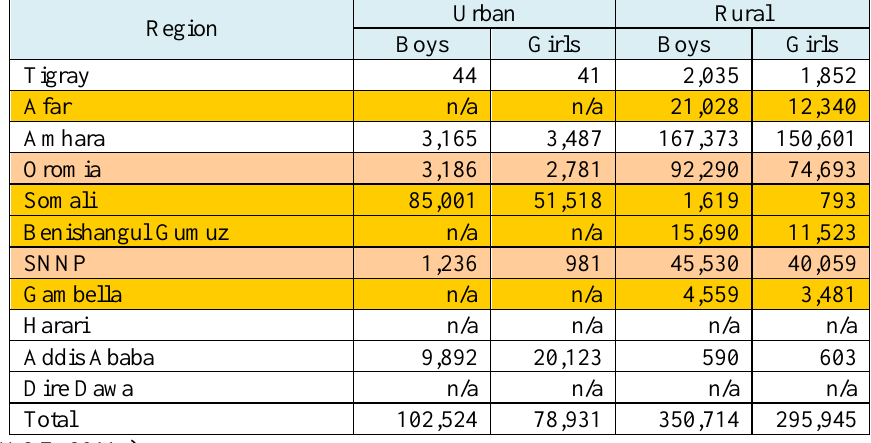
Table 4-3: Enrollments in ABE by Region and Urban/Rural Areas (2010/11) (number) Urban Rural Region Boys Girls Boys Girls Tigray 44 41 2,035 1,852 Afar n/a n/a 21,028 12,340 Amhara 3,165 3,487 167,373 150,601 Oromia 3,186 2,781 92,290 Somali 85,001 51,518 1,619 793 1,236 40,059 Gambella n/a n/a 4,559 3,481